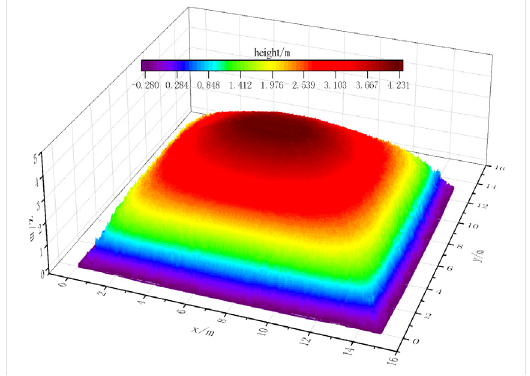
Figure 23. 3-D surface of test model.